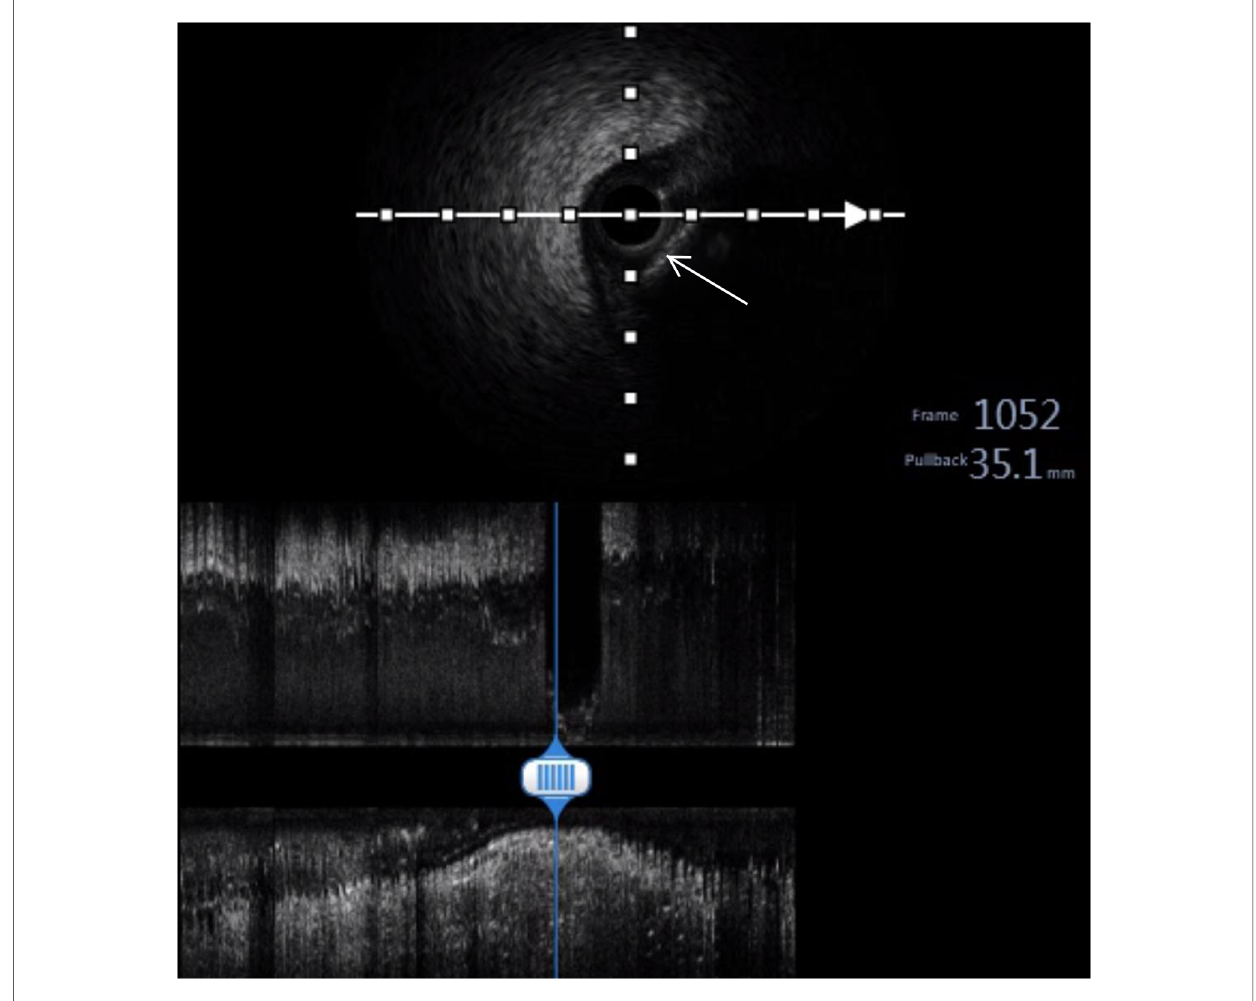
FIGURE 3 Intravenous ultrasound (IVUS). IVUS showing calci fi cation and posterior echo attenuation in the middle RCA (white